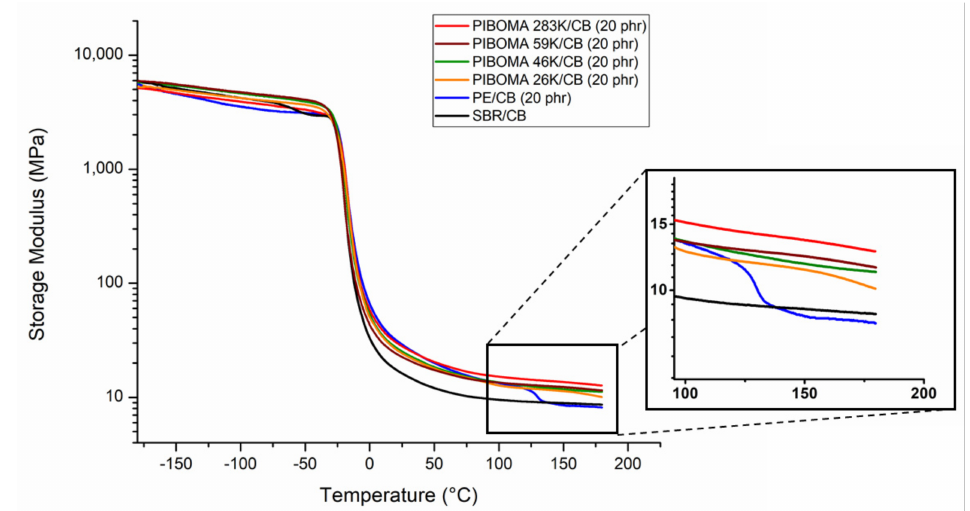
Figure 4. The storage modulus as a function of temperature for vulcanized rubber compounds containing 50 phr of CB and filled either with 20 phr of PIBOMA having various molecular weights or with 20 phr of UHMWPE.